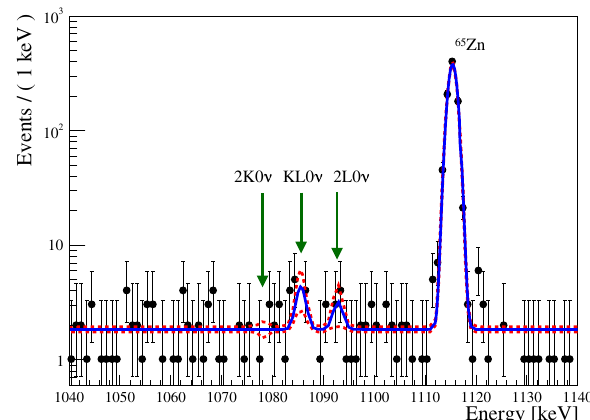
Fig. 4 Energy spectrum focused on 0 ν 2 ε ROI. The peak at 1115 keV is given by the 65 Zn decay. The blue line marks the best fit result, while the red dashed lines report a 1 σ statistical fluctuation of the number of counts of all the